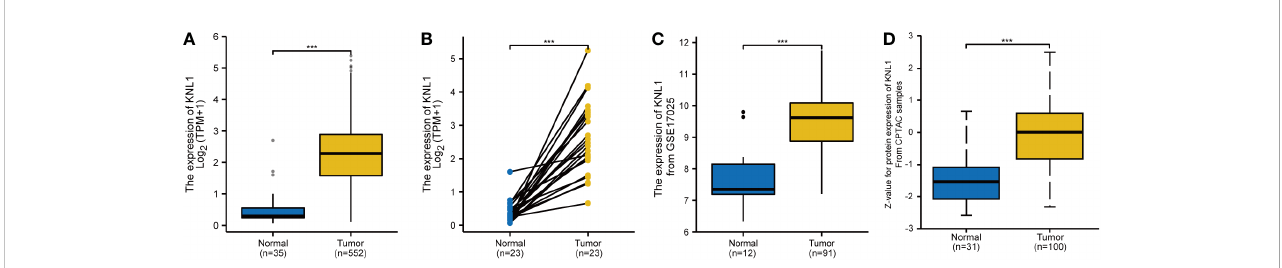
FIGURE 1 Differential expression analysis of KNL1 in patients with UCEC. (A) Differential analysis of KNL1 expression in unpaired UCEC samples. (B) Differential analysis of KNL1 expression in paired UCEC samples. (C) Differential analysis of KNL1 expression based on GSE17025 data. (D) Differential analysis of KNL1 protein expression based on CPTAC data. Signi fi cance identi fi er: ***,